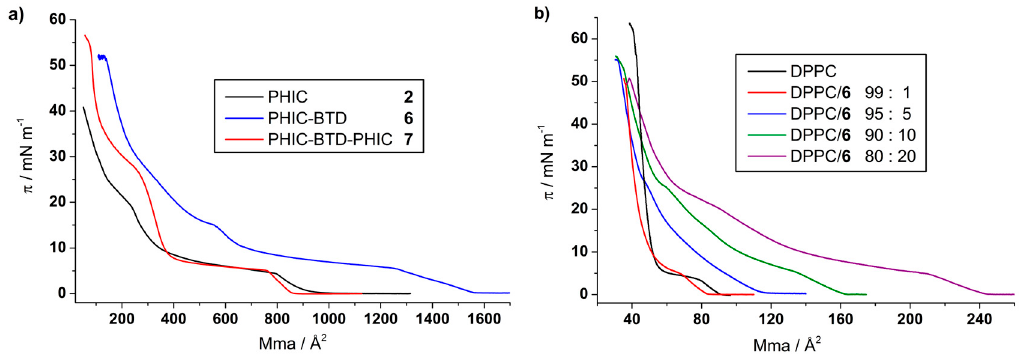
Figure 5. π -A isotherms of ( a ) the pure PHIC 2 and of β -turn mimetic conjugates 6 and 7 and of ( b ) DPPC/ 6 mixtures at 20 °C. The black curve represents the isotherm of the pure DPPC and the different colored curves represent the different molar ratios of the DPPC/polymer mixtures.